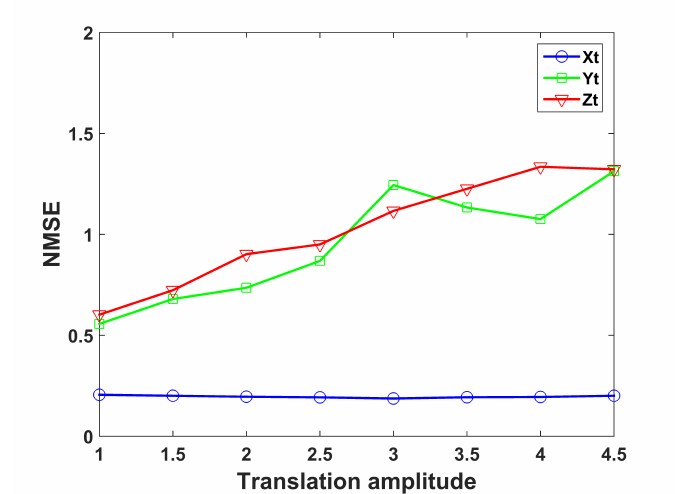
Figure 13. NMSE of the imaging results when only one translational component exists at different